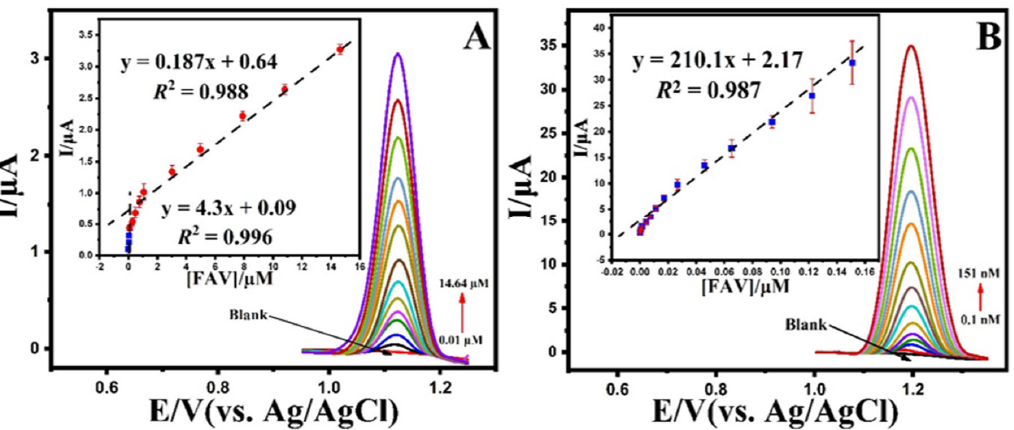
Figure 5. DPVs obtained at the ( A ) NIP ‐ Co/Ni@MOF/SPE and ( B ) MIP ‐ Co/Ni@MOF/SPE in 0.1 M B ‐ R buffer (pH 4.0) in the various concentration (0.01 to 14.64 μ M for NIP ‐ Co/Ni@MOF/SPE and 0.1 to 151.0 nM for MIP ‐ Co/Ni@MOF/SPE) of the FAV (insets). The calibration plot of current change vs. concentration of FAV. Condition; modulation amplitude: 0.05 V, modulation time: 0.01 s, inter ‐ val time: 0.1